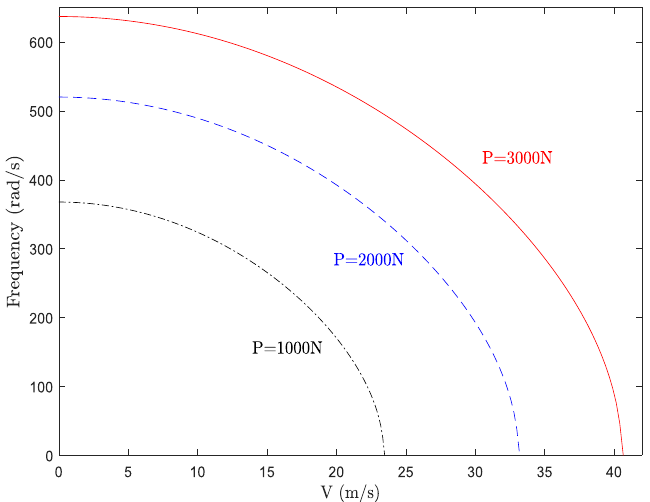
Figure 5. Fundamental frequency of an axially moving isotropic beam against axial velocity.